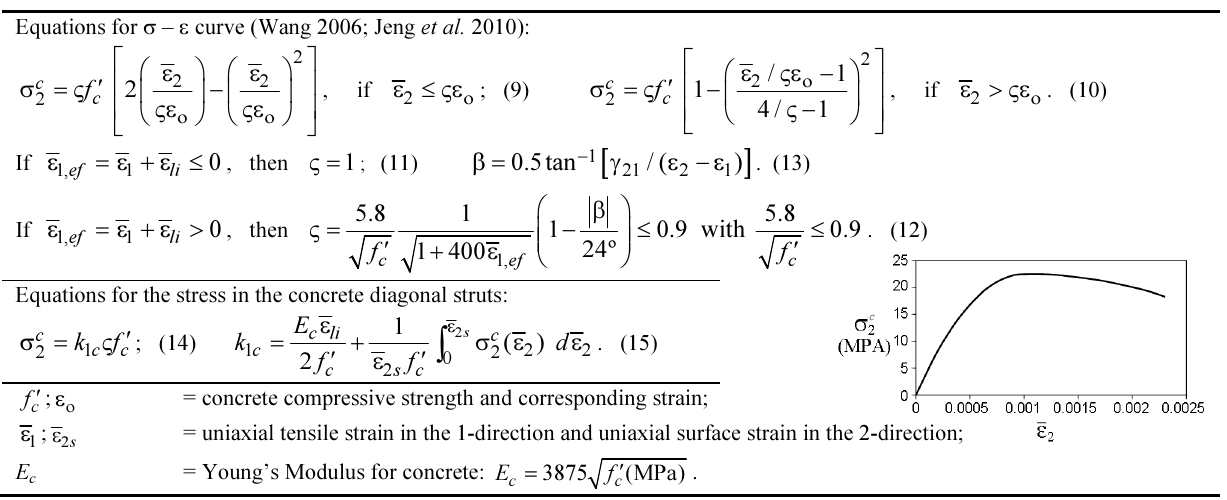
Table 2. σ – ε relationship for concrete in compression for PC beams (for RC beams: 0 li ε =